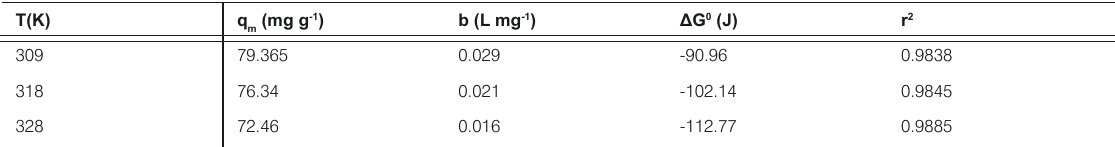
Figure 5. Langmuir isotherm plots for the sorption of CR by PKC at different temperatures (K). Table 3. Langmuir isotherm constants for CR at various